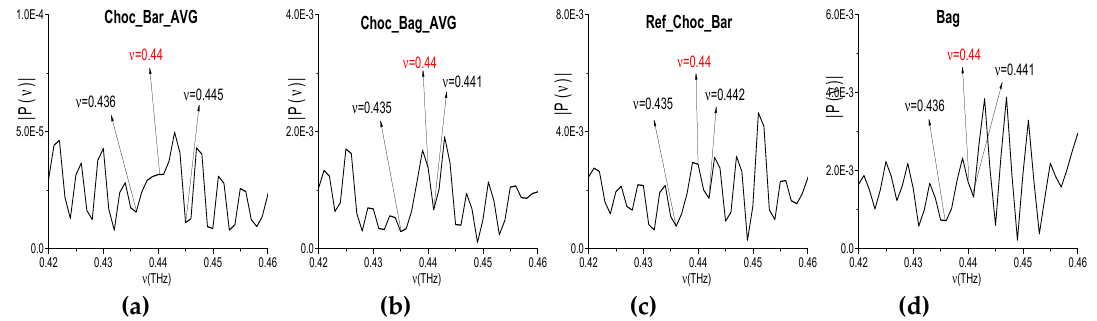
Figure 23 . Spectra of the narrowband Choc_Bar_AVG (a), Choc_Bag_AVG (b) signals and the Figure 23. Spectra of the narrowband Choc_Bar_AVG ( a ), Choc_Bag_AVG ( b ) signals and the reference reference spectrum (c), and the Bag one (d) in the frequency range ν = [0.42, 0.46] THz . spectrum ( c ), and the Bag one ( d ) in the frequency range ν = [0.42, 0.46]